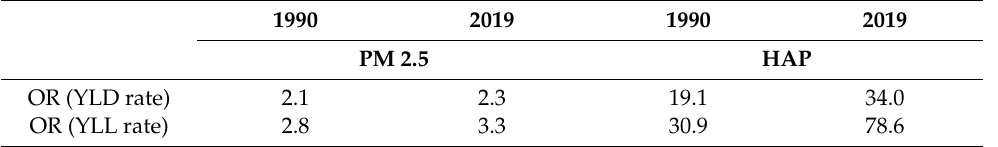
Figure 6. Distribution of the parameters of healthy life years lost (YLL and YLD) due to chronic diseases caused by air pollution per 100,000 population aged 20–54 (by EU-27 groups, 1990 and 2019). Table 5. OR index: “odds” on the occurrence of negative consequences of chronic conditions (premature death or health loss) as a result of air pollution among the inhabitants of Central and Eastern Europe compared to the inhabitants of the EU-14 countries (in 1990 and